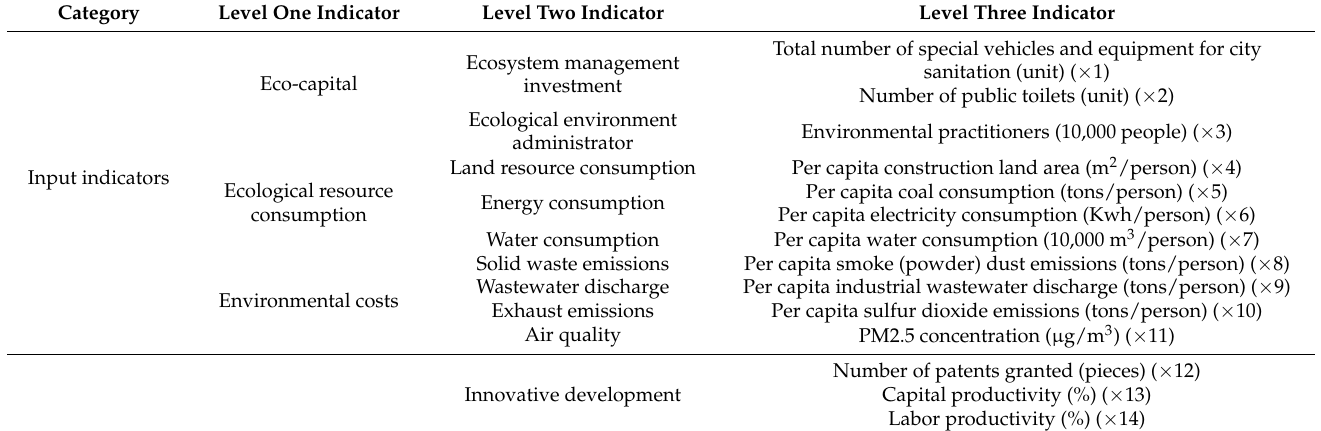
Table 1. Comprehensive evaluation system of urban ecological welfare